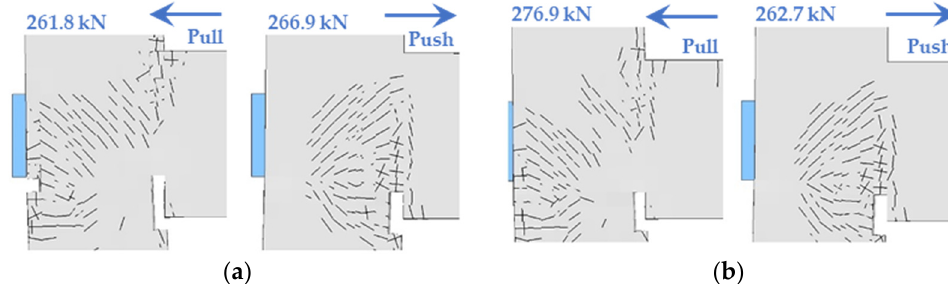
Figure 12. Failure patterns at the column–beam joints of the first two models at a drift ratio of 2.75%: ( a ) HI-C25 model; ( b ) LI-C25 model.